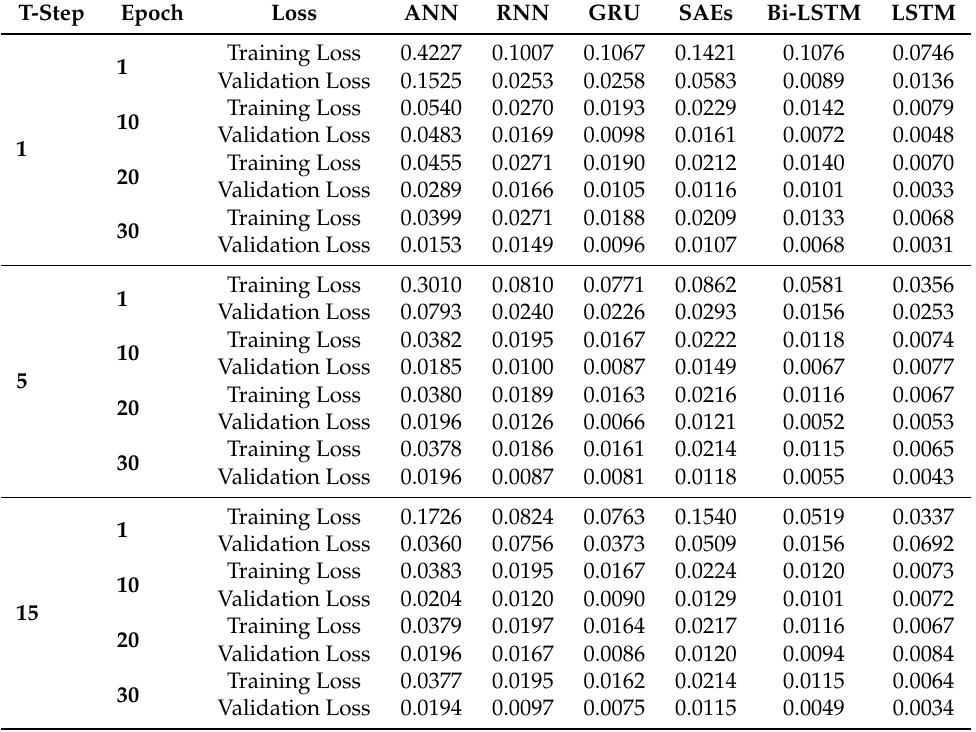
Table 1. Training and validation loss of different algorithms in different time